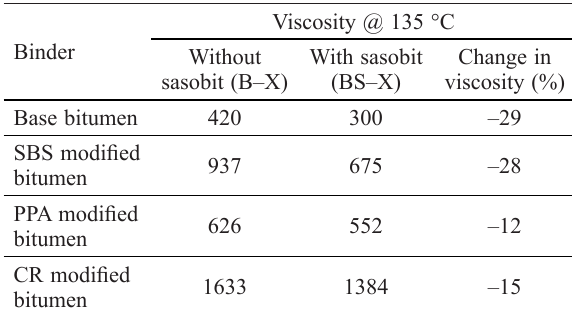
Fig. 6. The parameter G* versus temperature for unaged base and modified bitumen